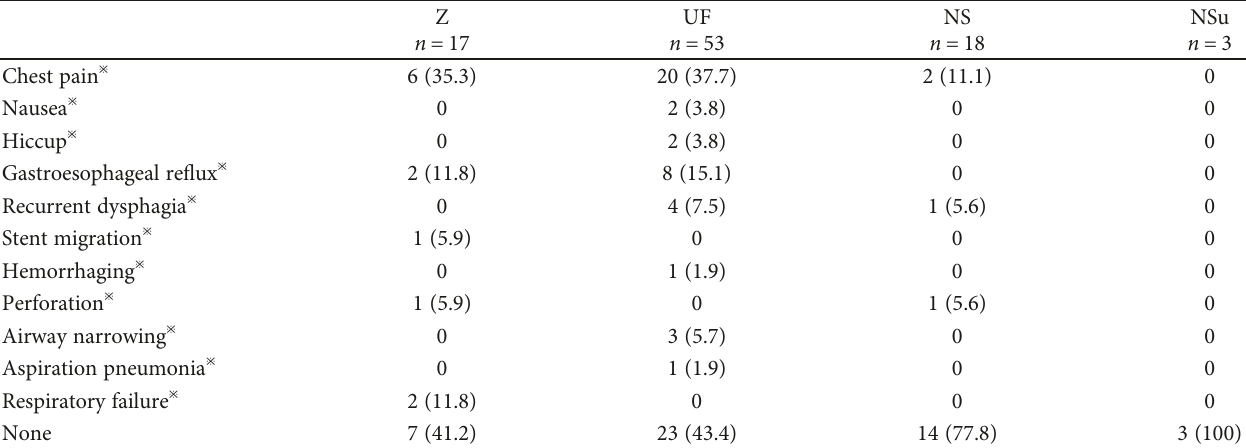
Table 7: Relationships of complications and types of SEMS ( n = 91 times, number